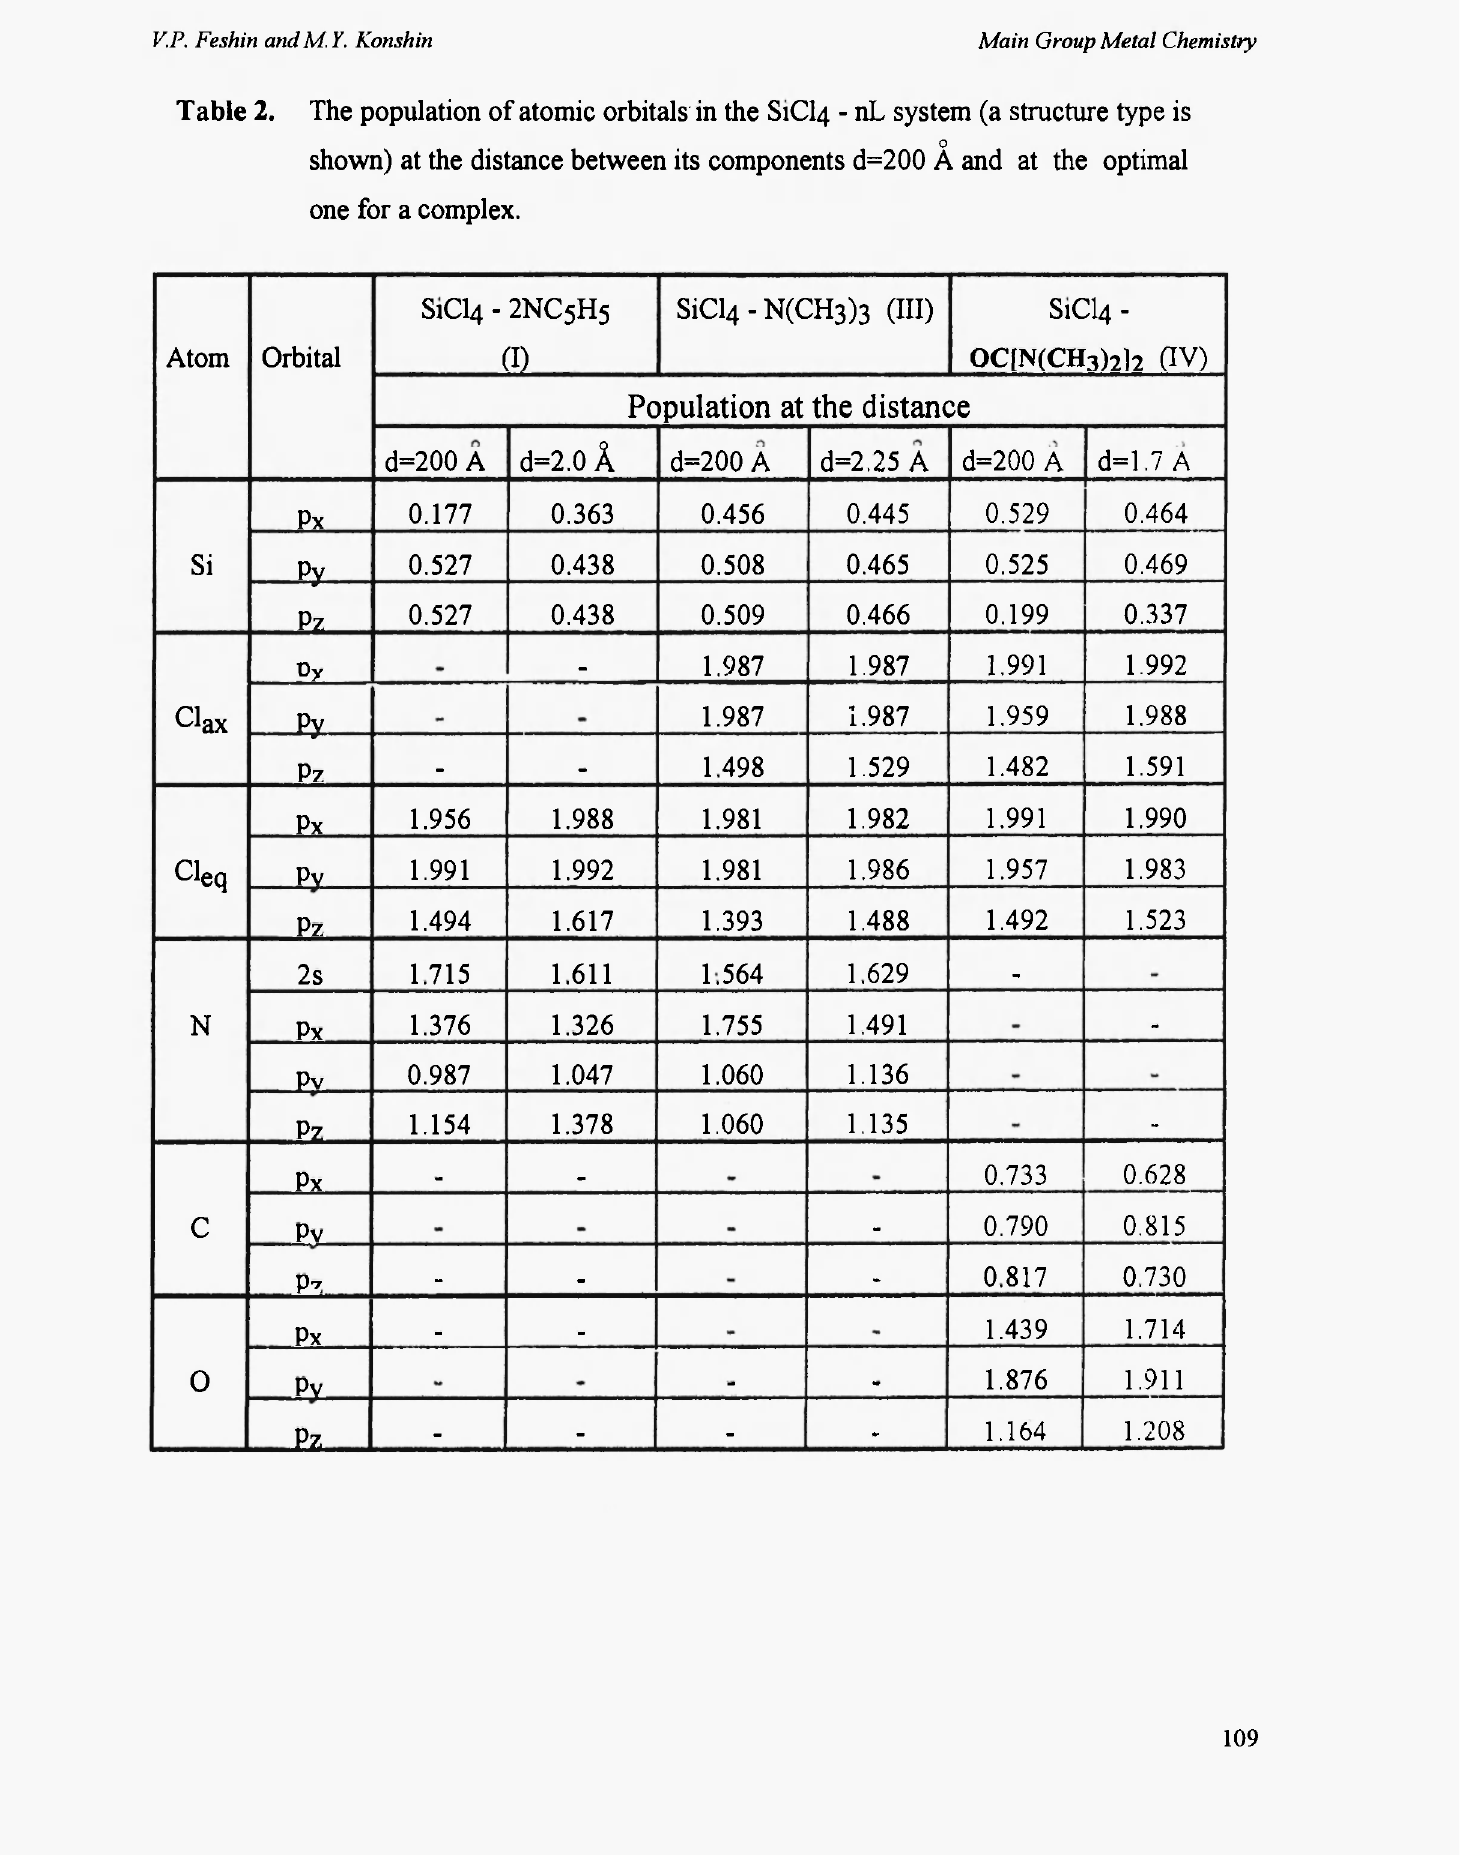
Table 2. The population of atomic orbitals in the S1CI4 - nL system (a structure type is shown) at the distance between its components d=200 A and at the optimal one for a